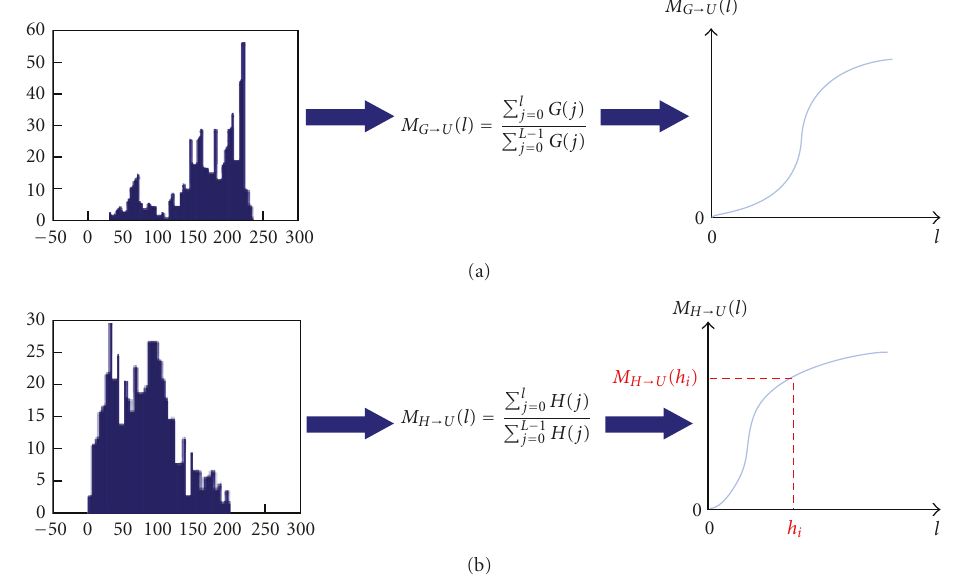
Figure 2: The candidate and target histograms, and their corresponding distributions.